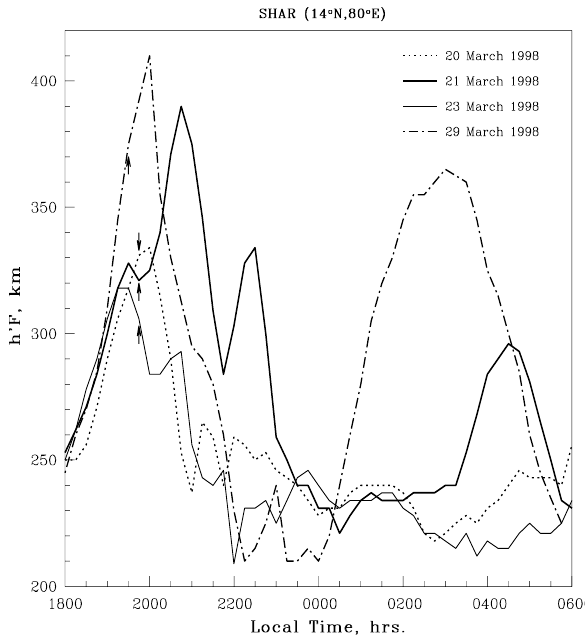
Fig. 3. Variation of h’F over SHAR during the nights of 20, 21, 23 and 29 March 1998. Arrows show the time of onset of spread